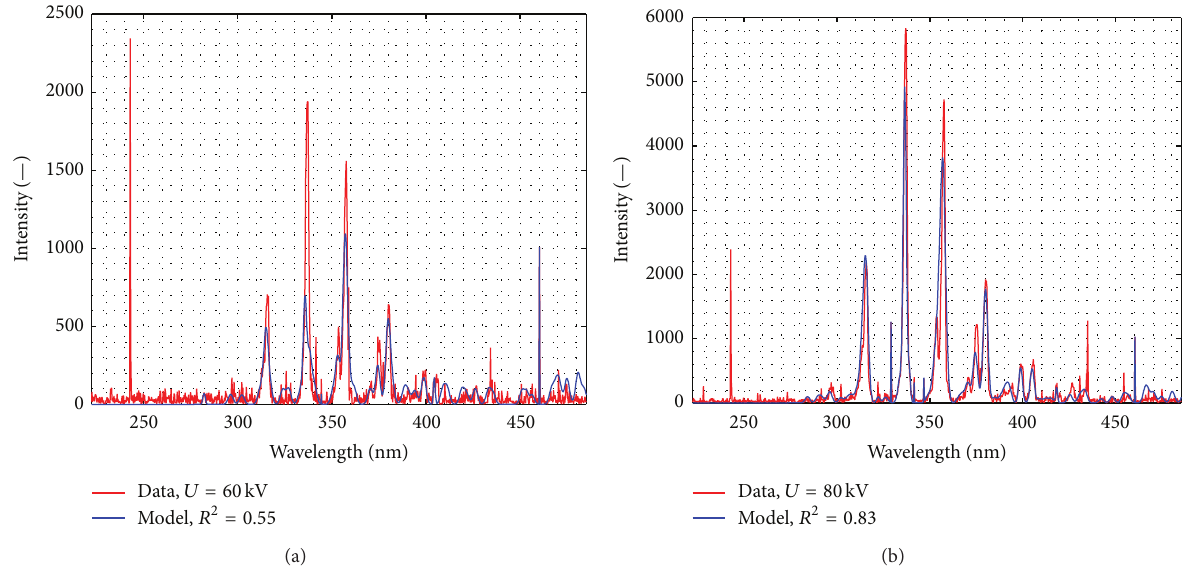
Figure 11: Intensity spectra of recorded and modeled light emission for selected values of PD generation voltages: (a) 0.56 𝑈 𝑝 = 60kV and (b) 0.89 𝑈 𝑝 = 80 kV.